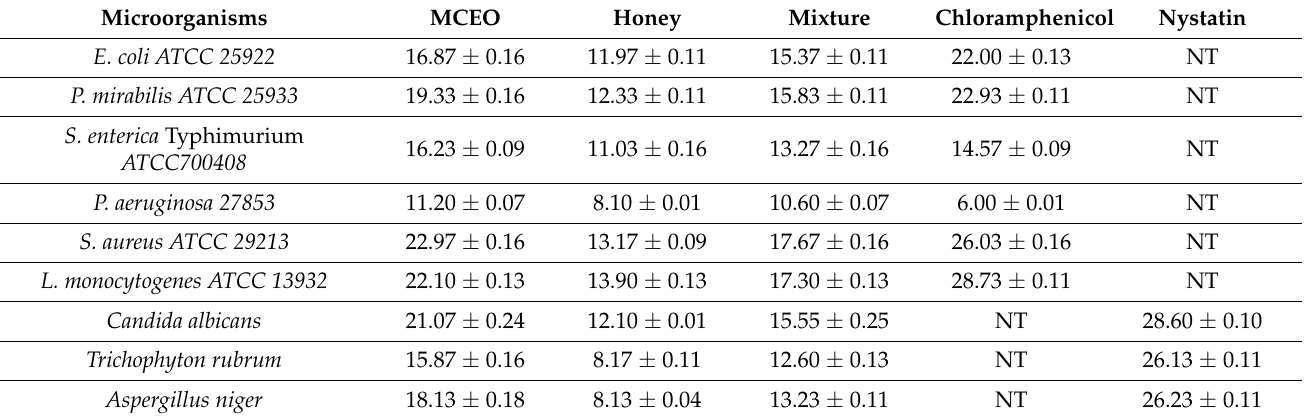
Table 7. The inhibitory diameters (mm) of MCEO, M. chamomilla honey, and their